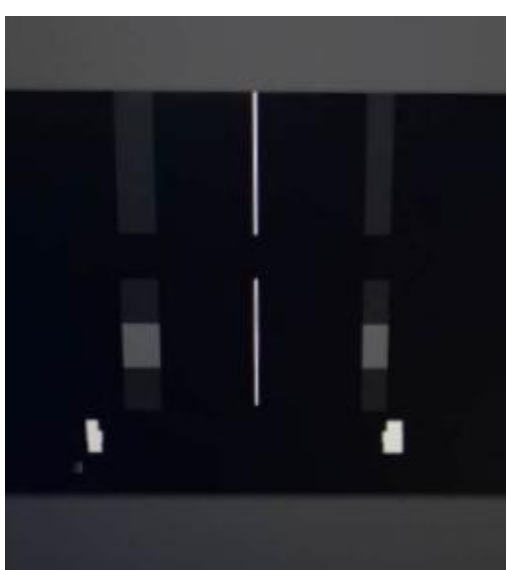
Figure 10. Distribution of acceleration sensors pasted on PM.